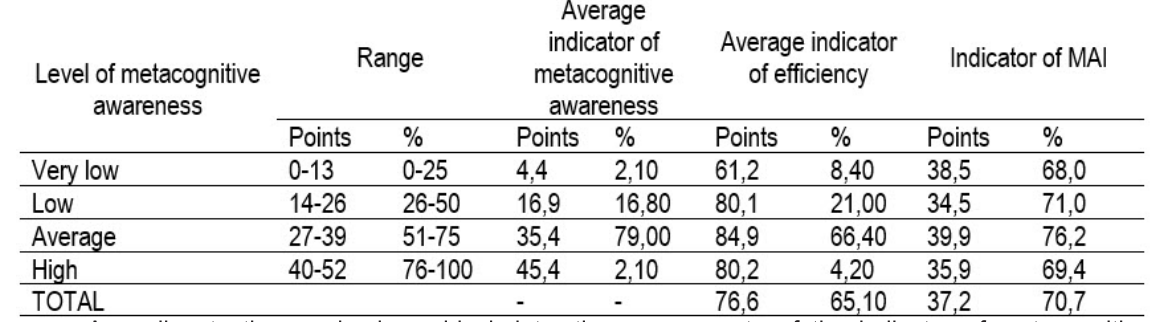
Levels of students’ metacognitive